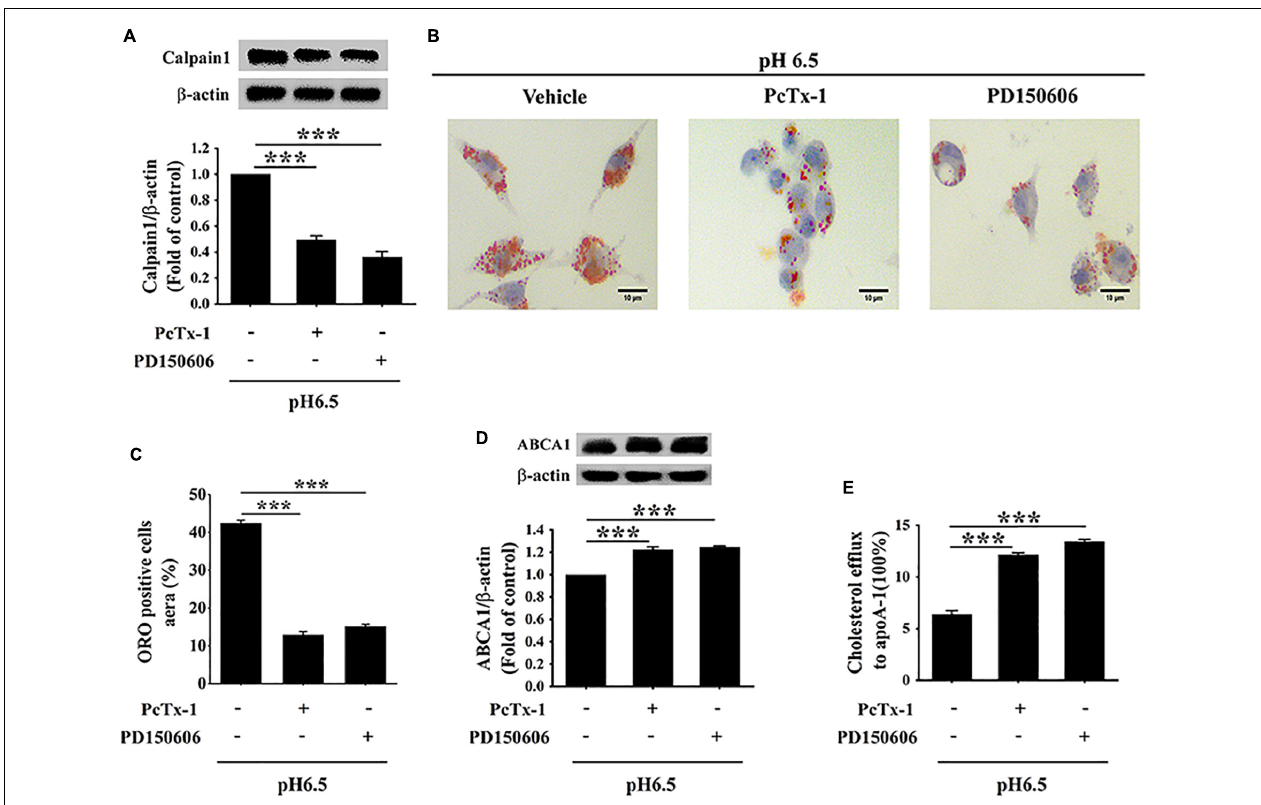
FIGURE 6 | Extracellular acidification increases macrophage lipid deposition via activating ASIC1/calpain1 to reduce ABCA1-dependent cholesterol efflux. RAW 264.7 macrophage cells were incubated in pH 6.5 culture medium with or without ASIC1 specific inhibitor PcTx-1 (100 ng/ml) or calpain1 inhibitor PD150606 (50 µ M) for 24 h. (A) Calpain1 expression was evaluated using WB analysis. (B) Lipid deposition was detected using ORO staining. (C) ORO staining positive areas were quantified. (D) ABCA1 expression was measured using WB analysis. (E) ABCA1-mediated cholesterol efflux was measured using the NBD-cholesterol kit. Data were shown as the mean ± SEM from 3 to 4 independent experiments. Statistical analysis was performed by one-way ANOVA. *** P <